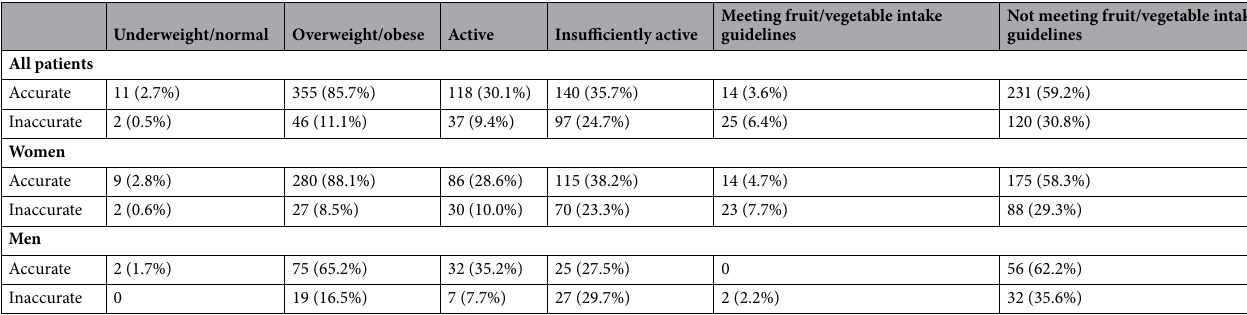
Table 3. Rates of concordance between actual and self-perceived weight status and energy balance behaviors at baseline in the overall population.